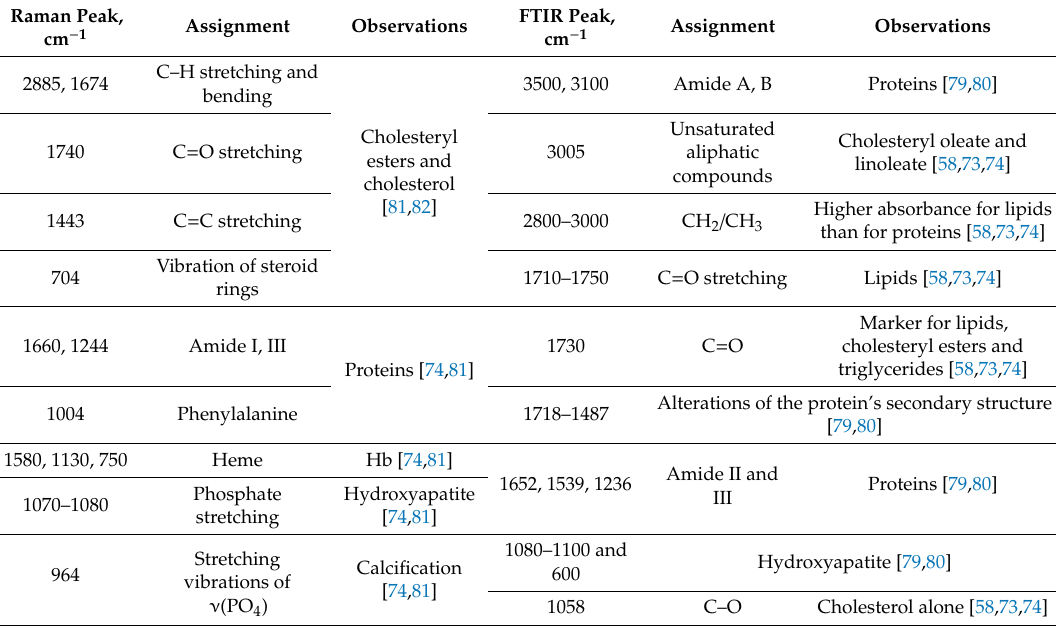
Table 1. Typical Raman and FTIR band allocations in atherosclerosis